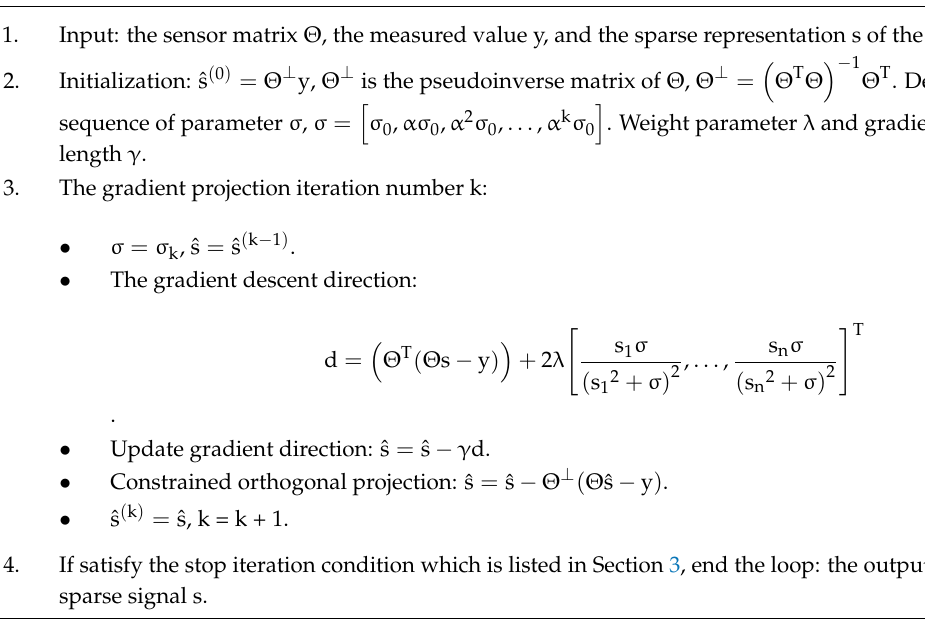
Algorithm 1. Approximation Minimum L 0